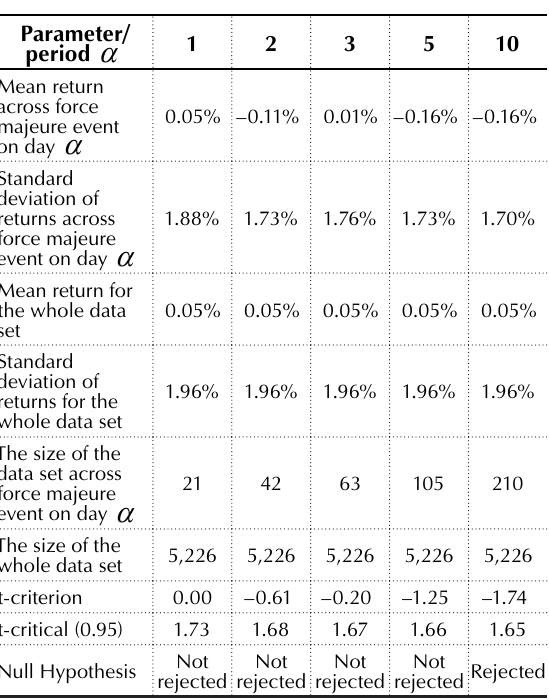
In this case, unlike the previous ones, there is no pat- tern in price behavior on the day of the event, and the longer the time horizon the higher cumulative abnormal returns are. To see whether the detected differences in returns are statistically significant a t -test is again performed (see Table 15). The null hy- pothesis is rejected only for the case of 10. α = Table 15. T -test for the PFST returns over the period 1991–2018: technological